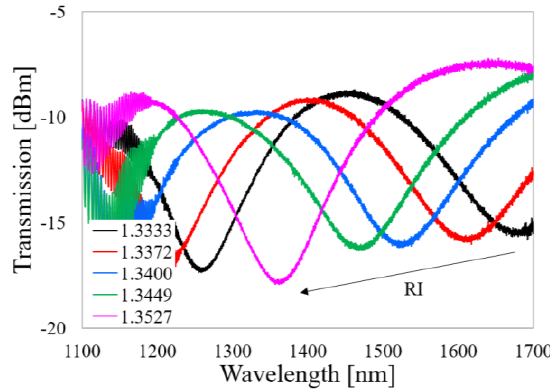
Figure 4. Spectral response of the reference µIMZI with cavity diameter d = 60 µm. An arrow indicates the shift of the minimum with RI.